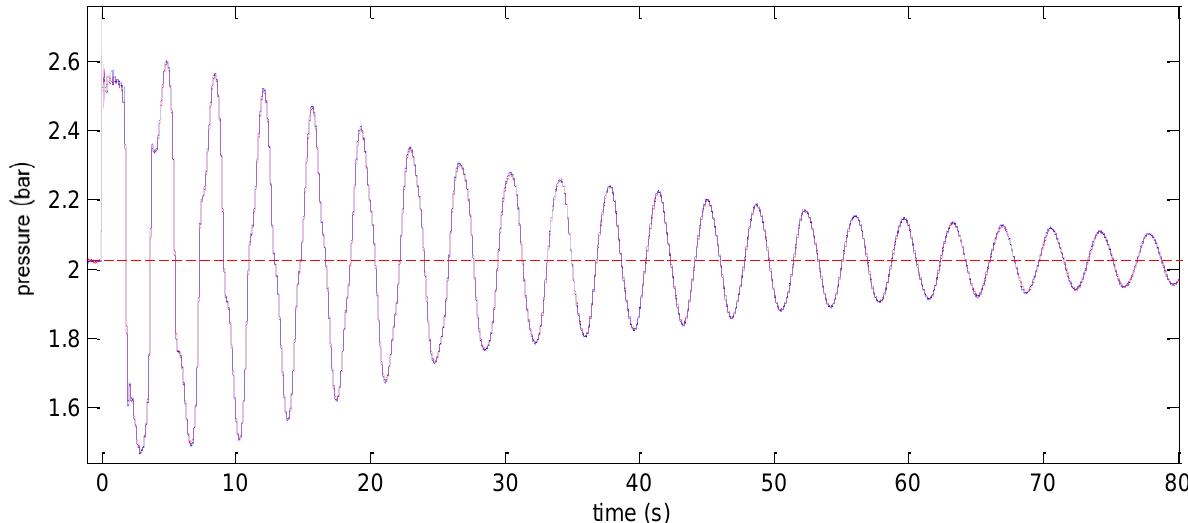
Fig 8. Pressure p measured by the transducer close to the downstream valve for two repeated experiments. dv